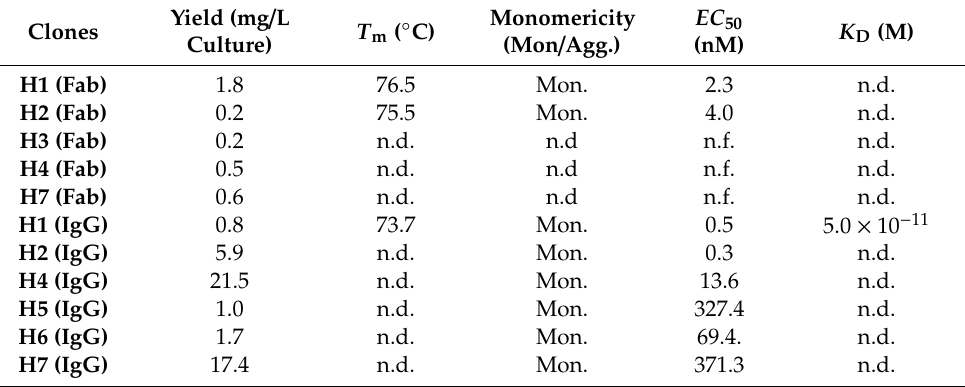
Table 1. Physicochemical properties of human anti-hYKL-40 monoclonal antibodies (mAbs). Yield (mg / L Clones